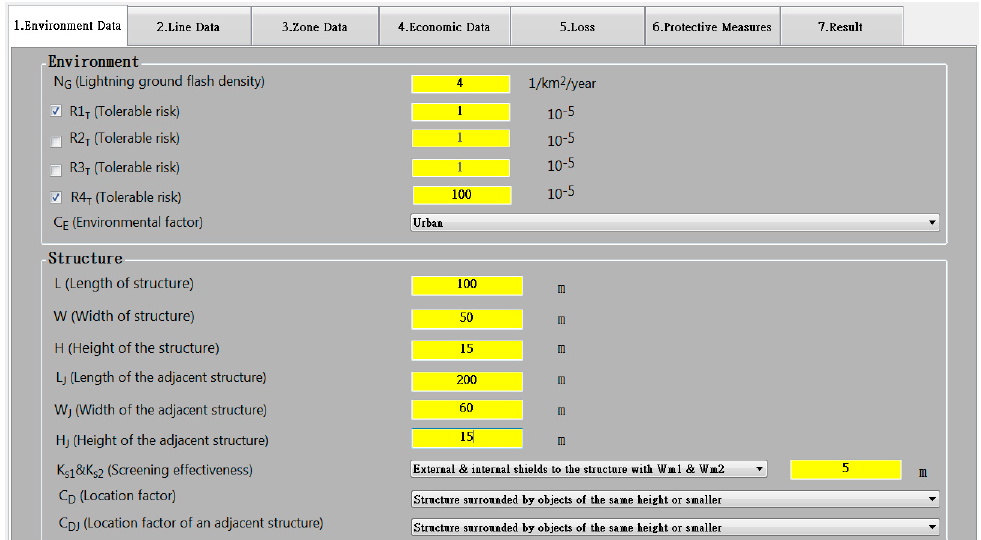
Figure 4. The environment data.